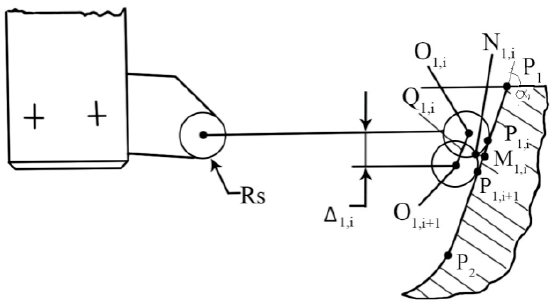
Figure 2. The occurrence of the geometric deviation—rectilinear generator curve.